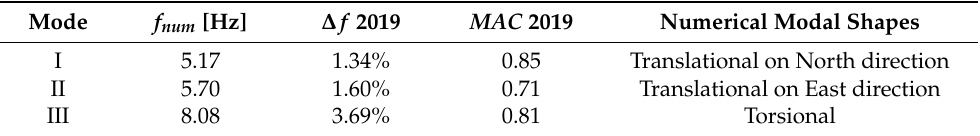
Table 5. Comparison of the modal frequencies and shapes between the final FEM realized and the OMA results obtained by the 2019 field